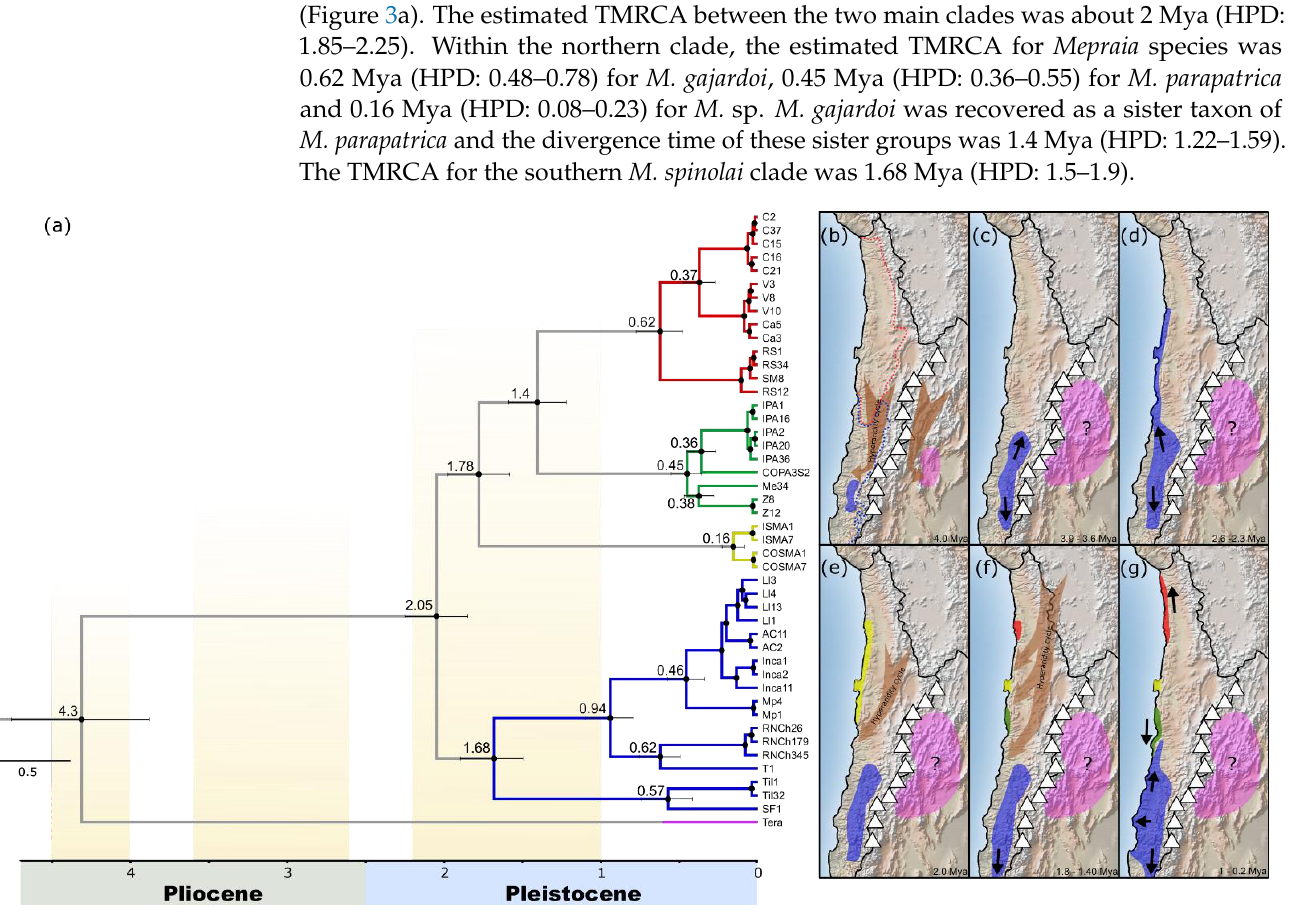
Figure 3. Most probable colonization scenario of Mepraia species inferred in BEAST and DIYABC using mitochondrial gene sequences (COI, cyt b and ND4). ( a ) Bayesian consensus tree with divergence times. The numbers at the nodes are the divergence times in millions of years; the black bars at the nodes show the 95% HPD for node age. The black circles at the nodes indicate node support above 0.95 pp. The colour coding of the branches and areas in the map corresponds to the species shown in Figure 1. The timing of the hyperarid cycles is shown in the yellowish shaded area on the tree according to [27] and as brown arrows on the map. ( b – g ) illustrate the consecutive biogeographical events. The triangles on the maps illustrate the Andes Range after the last uplift. The red and blue dotted lines on map ( b ) delimit the Atacama and Coquimban Biogeographical Provinces, respectively, according to [17]. The black arrows on the maps indicate the colonization direction.